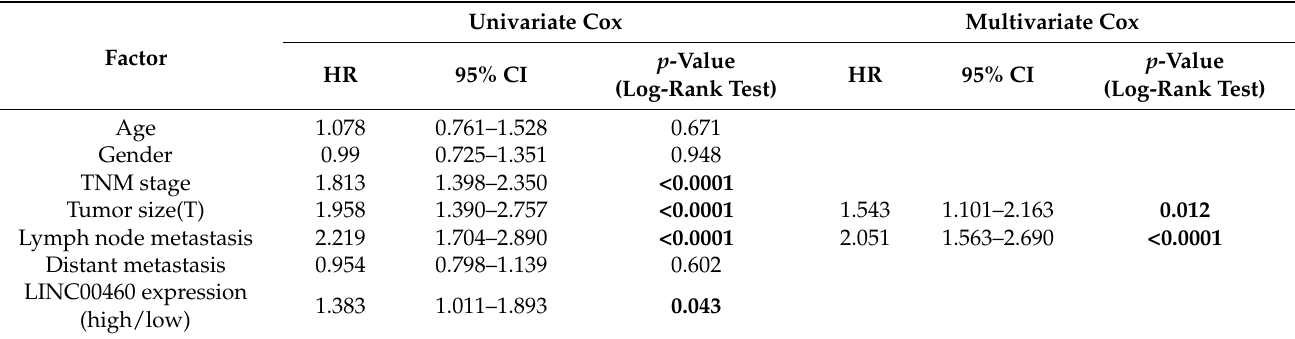
Table 2. Univariate and Multivariate analyses (Cox regression model) of LINC00460 in LUAD patients.